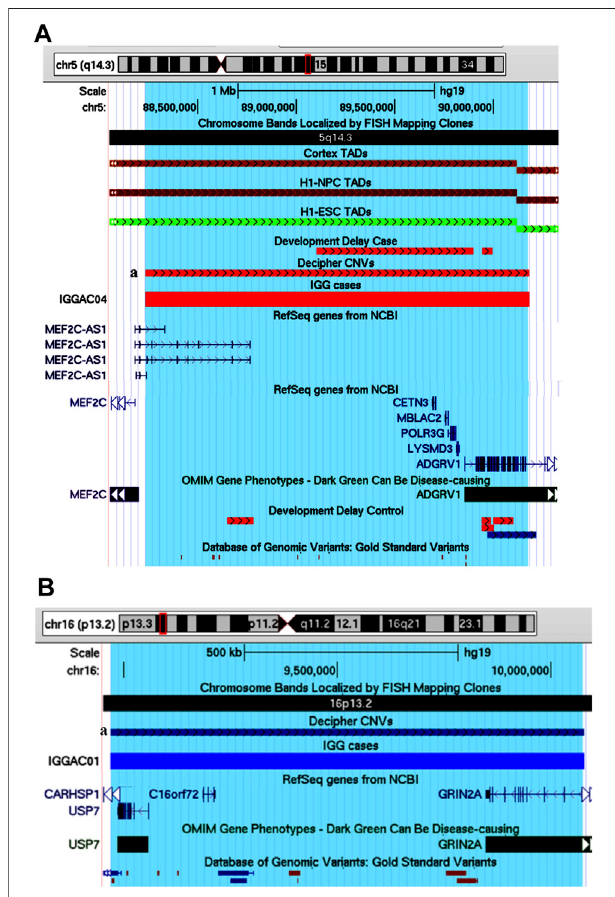
FIGURE8| Potentialcandidate genesandpathogeneticmechanisms in patient IGGAC04 and IGGAC01. (A) Screenshot of chromosome 5 region overlapping the deletion of patient IGGAC4 (red bar, chr5:88,232,587- 90,181,774). Decipher CNVs (a: deletion in patient 251716). TADs from Cortex, H1NPC and h-ESC cells. (B) Screenshot of chromosome 16 region overlapping the duplication of patient IGGAC01 (blue bar, chr16:8,969,984- 10,078,802). Decipher CNVs (a: duplication in patient